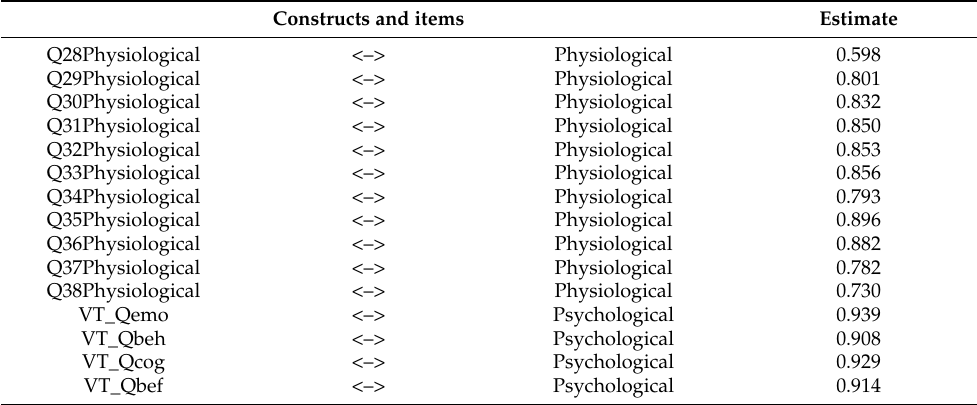
Table 7. Estimate regression of the constructs and